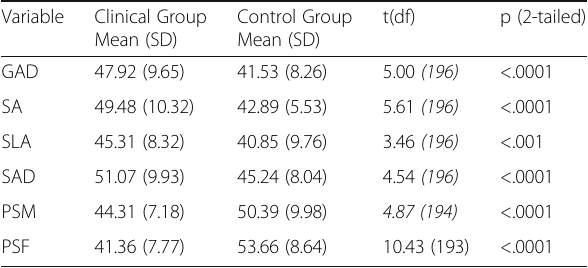
Table 2 Mean differences between clinical and control groups on anxiety and attachment security measures